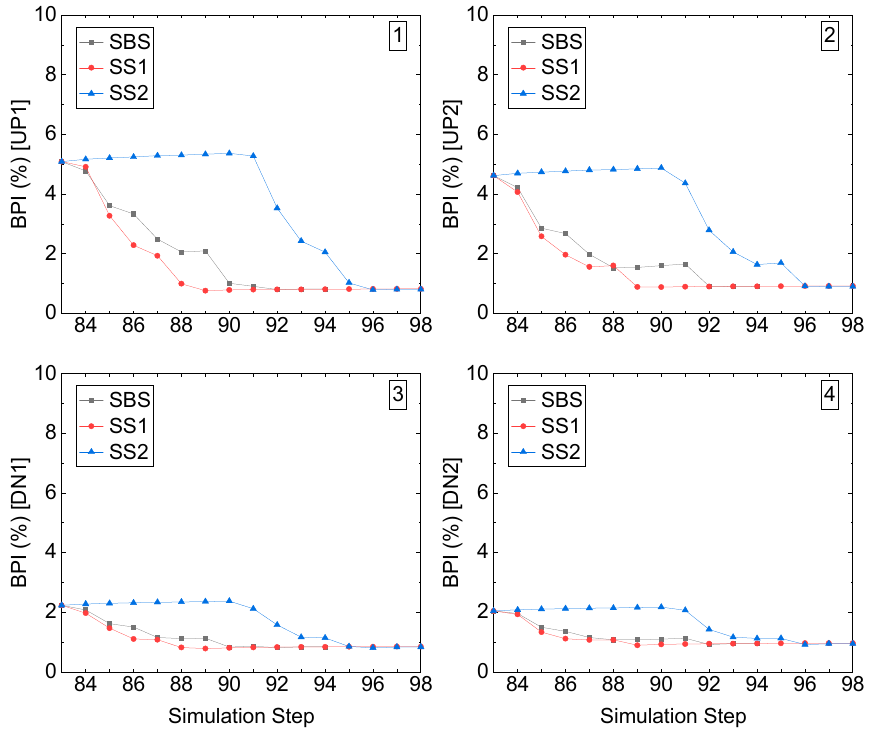
Figure 18. BPI value of the middle stope access to the undercut in Sill-1.